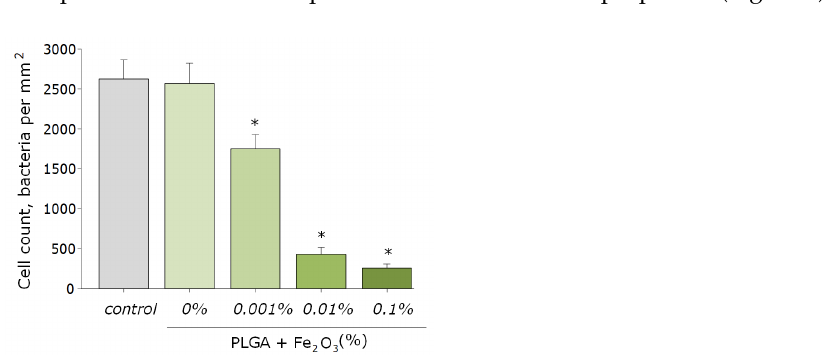
( b ) Figure 9. Influence of a nanocomposite based on PLGA and iron oxide nanoparticles on the leaf size of Capsicum annuum pepper plants ( a ). Data are presented as mean values and standard errors of the mean. On the right is a comparative photograph of random plants from groups (1) Control, (2) PLGA without nanoparticles and (3) PLGA with 0.1% iron oxide nanoparticles ( b ).